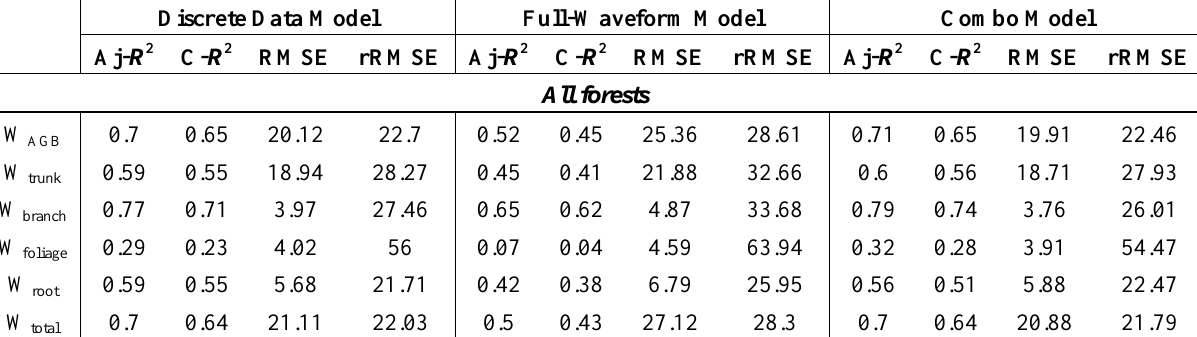
Table 3. The accuracy assessment results of three sets of predictive models among various forest